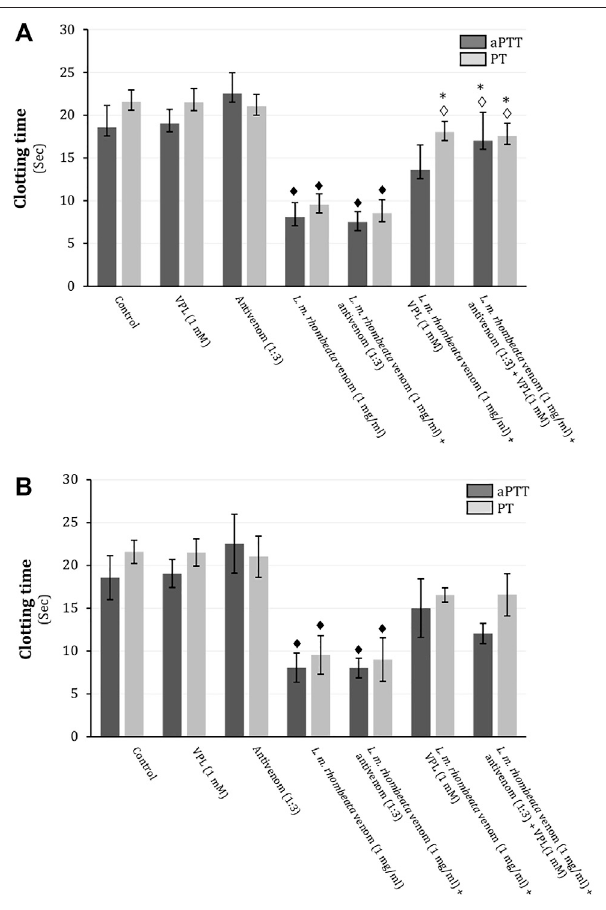
FIGURE 2 | Action of varespladib on the procoagulant activity of L. m. rhombeata venominratcitratedplasma invitro . (A) Antivenomdidnotprevent thevenom-inducedprocoagulantactionapplyingthepre-incubationprotocol, whereas varespladib alone avoided the procoagulant action for PT and its association with antivenom successfully prevented both intrinsic and extrinsic disorders. (B) Antivenom did not prevent the venom-induced procoagulant action applying the direct exposure protocol, whereas varespladib alone or combined with antivenom produced minor protective action on both coagulant pathways even combined with antivenom. Bars represent the mean ± SDM ( n (cid:1) 6). ◆ p < 0.05 compared to control, ◊ p < 0.05 compared to venom alone and * p < 0.05 compared to antivenom